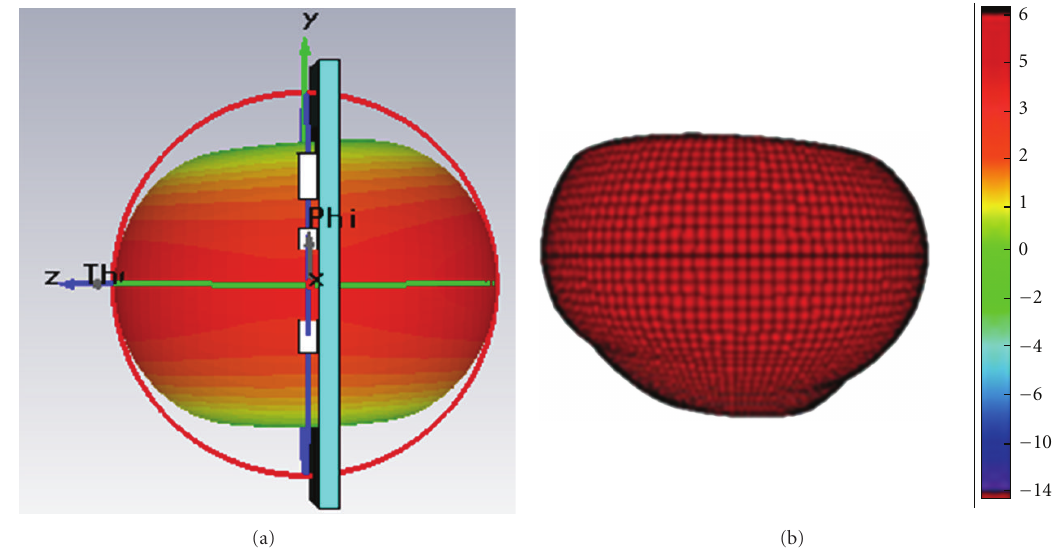
Figure 8: Radiation pattern of BiT in 3D view (a) simulated (b)